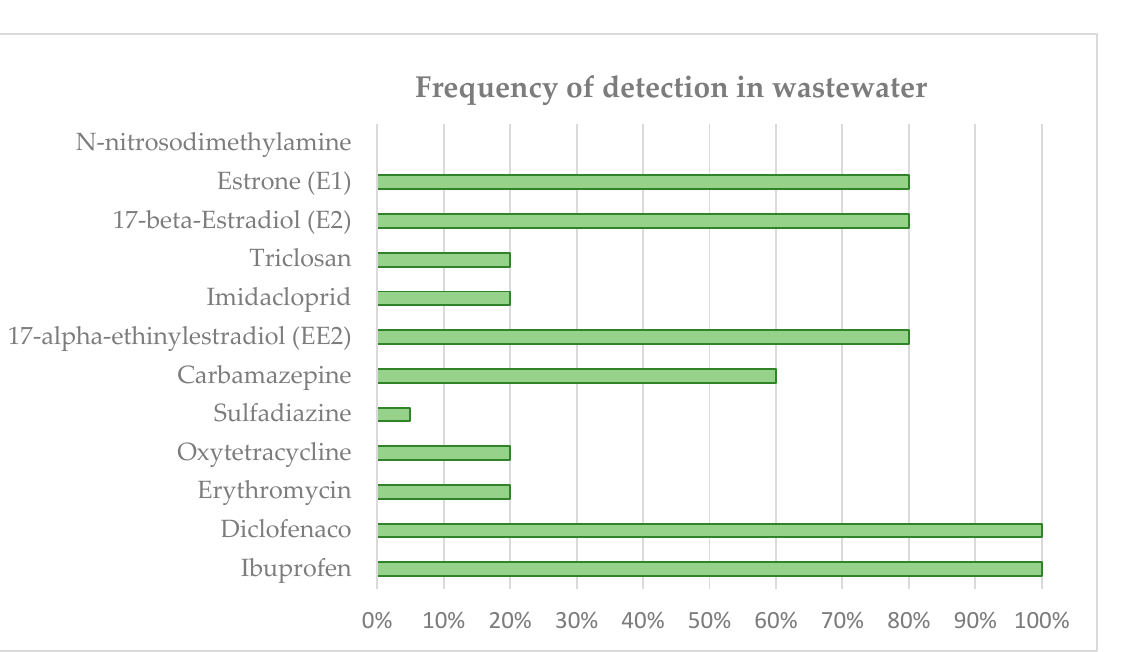
Table 4. Average pollutant removal efficiencies with different treatment technologies.